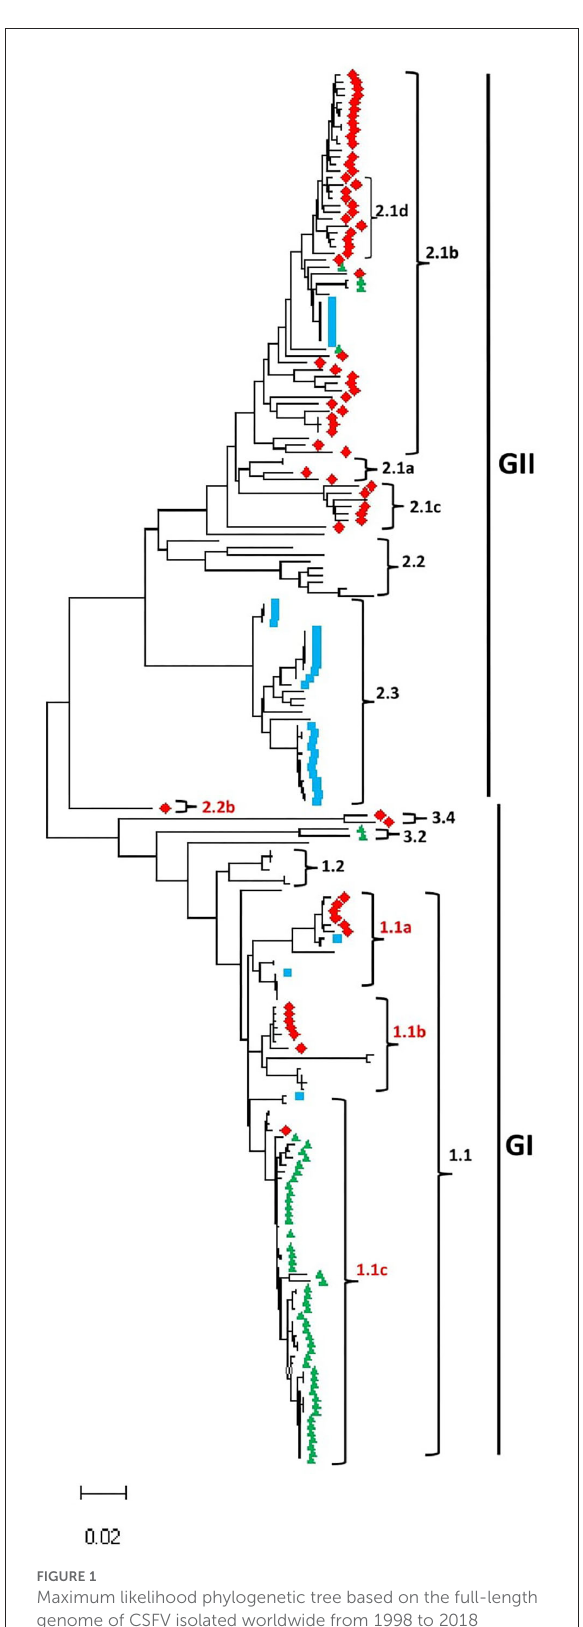
FIGURE1 Maximum likelihood phylogenetic tree based on the full-length genome of CSFV isolated worldwide from 1998 to